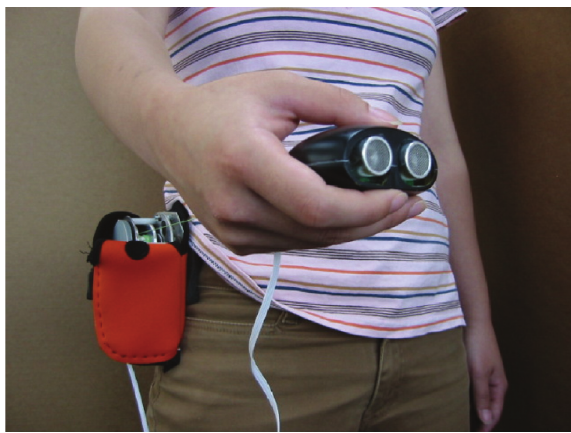
Figure 7: Practical use of CyARM.